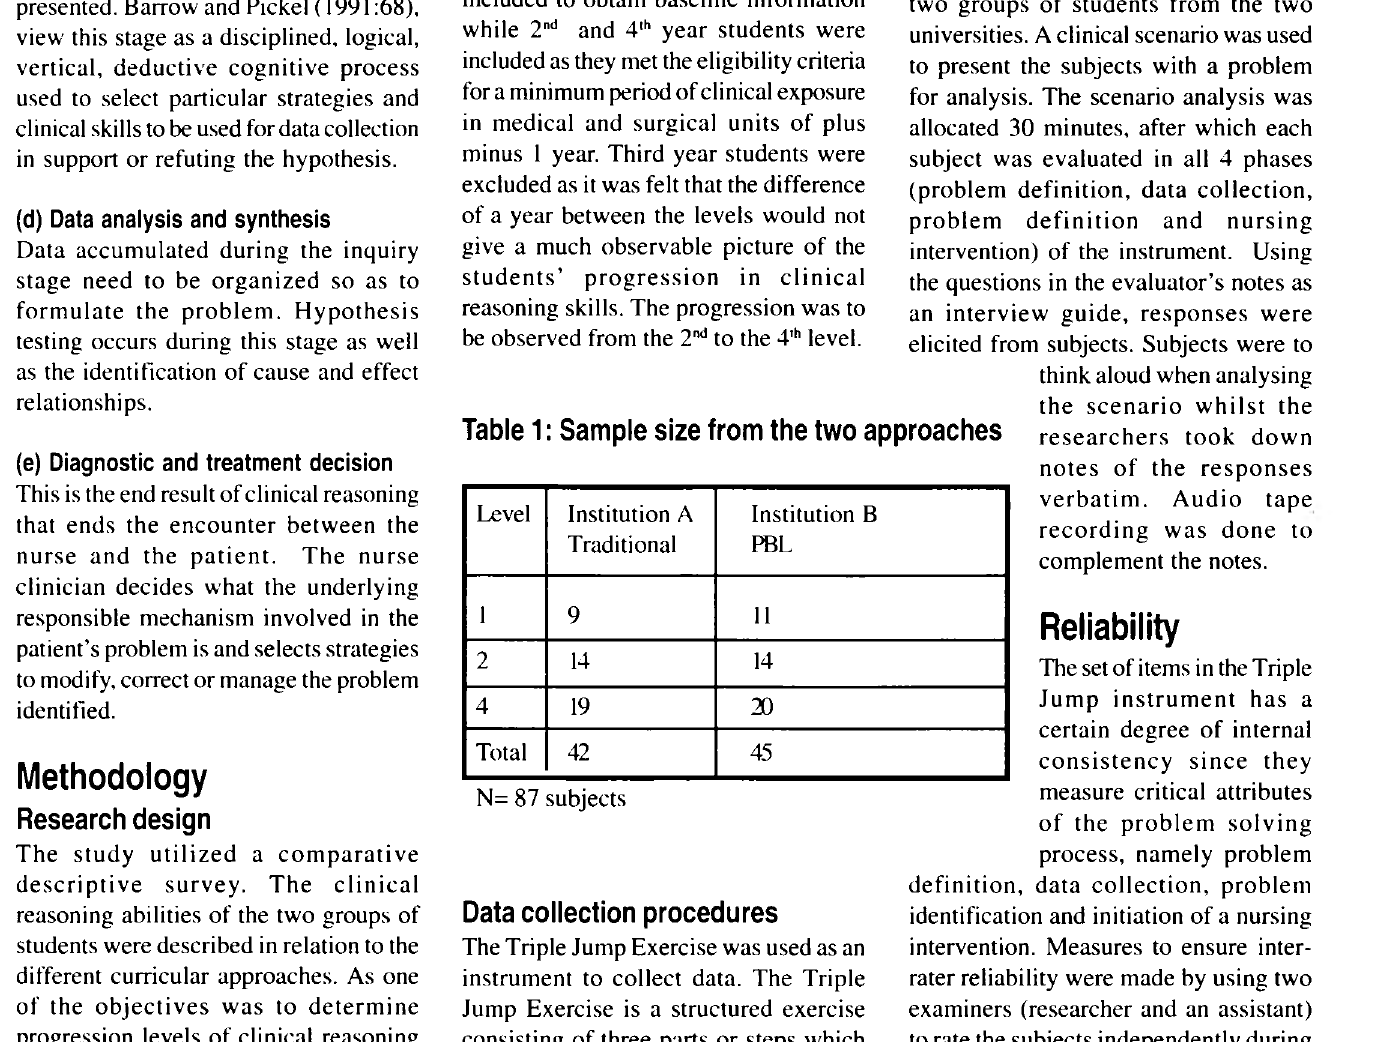
Table 1: Sample size from the two